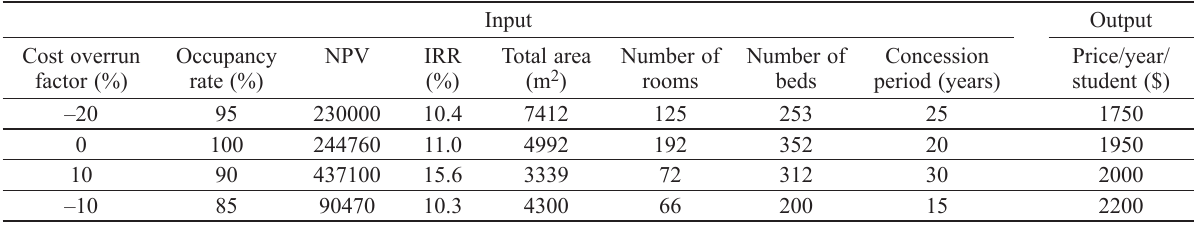
Table 3. Example of training data